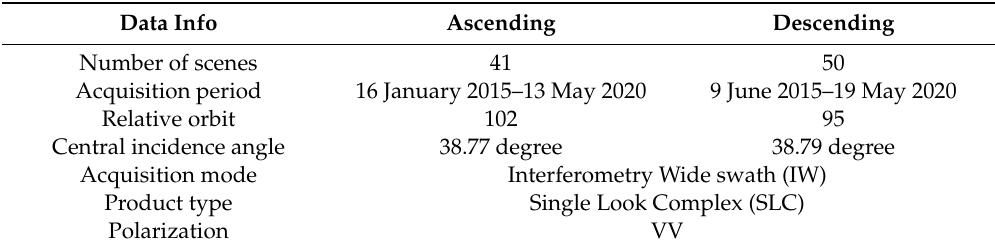
Table 1. Details of the Sentinel-1 A and B datasets used for the PSI time series analysis and their